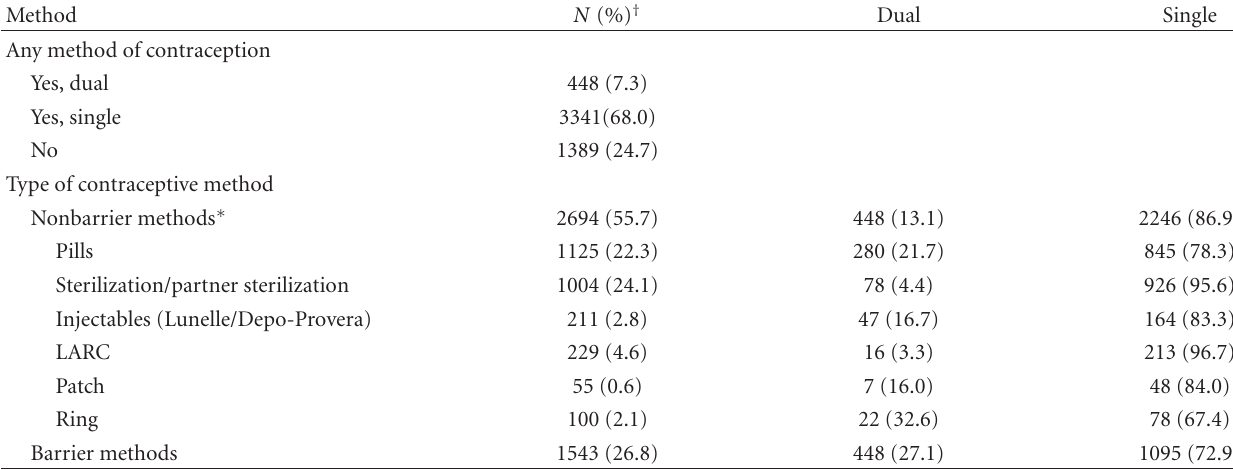
Table 1: Contraceptive methods used in the last intercourse in past 12 months by nonpregnant females aged 15–44 years, N = 5178.